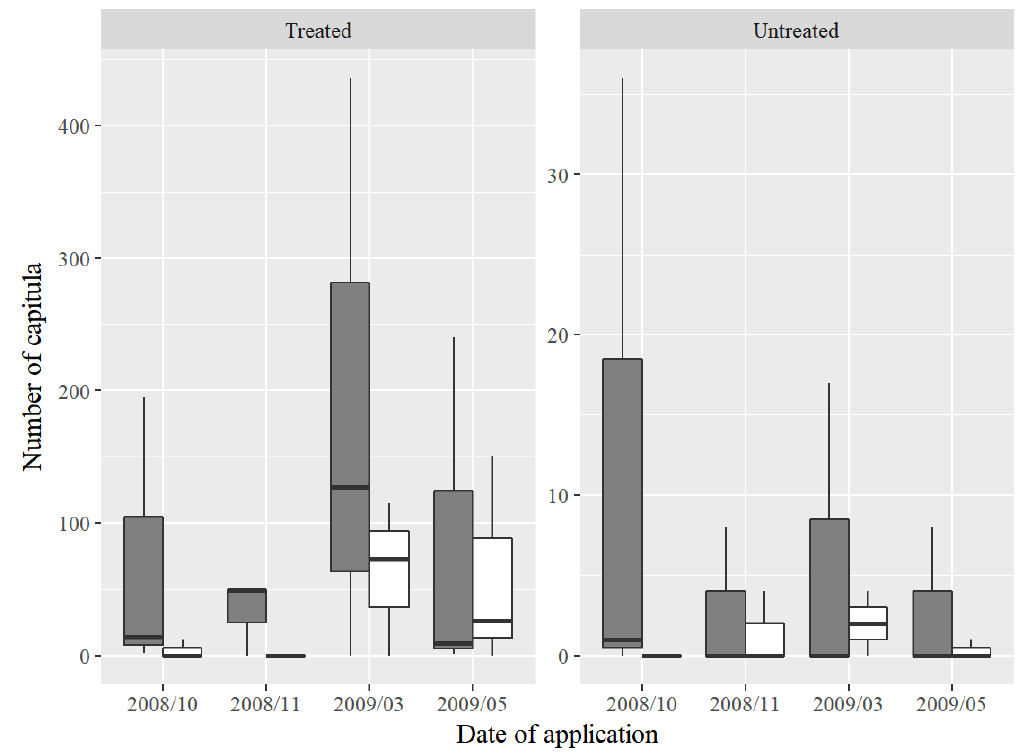
Figure 3. Number of S. fallax capitula recorded in June 2014 after application of Sphagnum beads in various months between October 2008 and May 2009, on either treated (with lime, fertiliser and grass seed, left- hand panel) or untreated (right-hand panel) peat surfaces (Trial A). In each application, half the plots were covered with heather brash (grey columns), whilst the other half remained uncovered (white columns). Note that the two panels have different y-axis